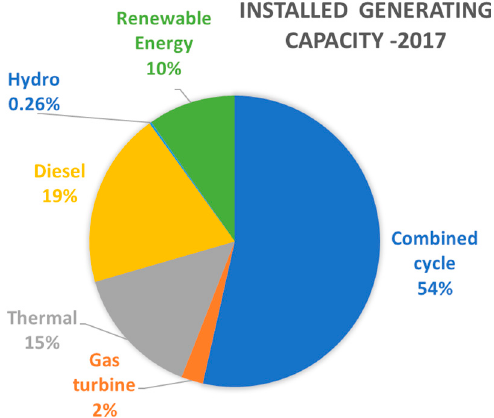
Figure 2. Share of Jordan installed generating capacity as on 20 June 2017 (based on the data from [11]).